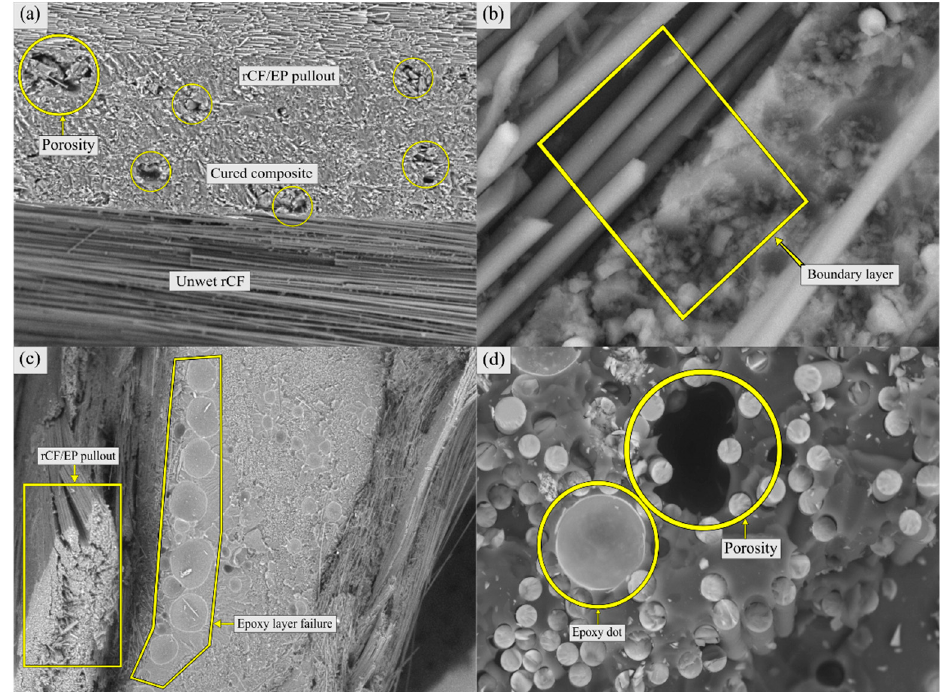
Figure 11. ( a ) Different layers in a single composite sample (60 wt% rCF/EP), ( b ) the boundary layer Figure 11. ( a ) Di ff erent layers in a single composite sample (60 wt% rCF / EP), ( b ) the boundary layer between un-wet fibres and the fully cured rCF/EP composite, ( c ) minor resin layers present in the between un-wet fibres and the fully cured rCF / EP composite, ( c ) minor resin layers present in the rCF/EP composites, and ( d ) the presence of resin dots and porosity in the rGF/EP composite. rCF / EP composites, and ( d ) the presence of resin dots and porosity in the rGF / EP